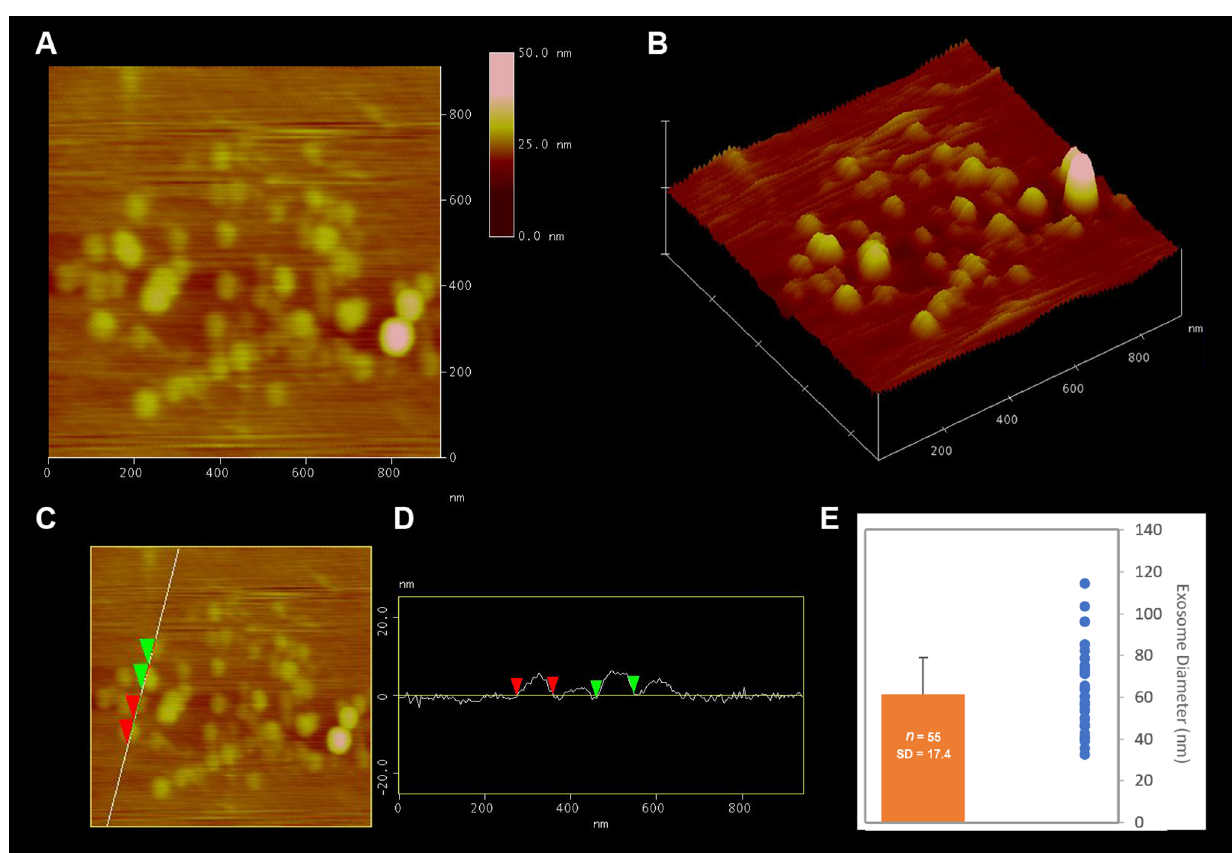
Figure 1. Atomic force micrograph of isolated exosomes demonstrates a distribution of 30–115 nm and an average size of 60 nm. ( A ) AFM 2-D micrograph of isolated exosomes placed on mica. ( B ) AFM 3-D micrograph of the isolated exosomes in A. ( C , D ) Cross-section analysis of exosomes, and ( E ) Bar graph of exosome size and the size distributions to the right as dots.